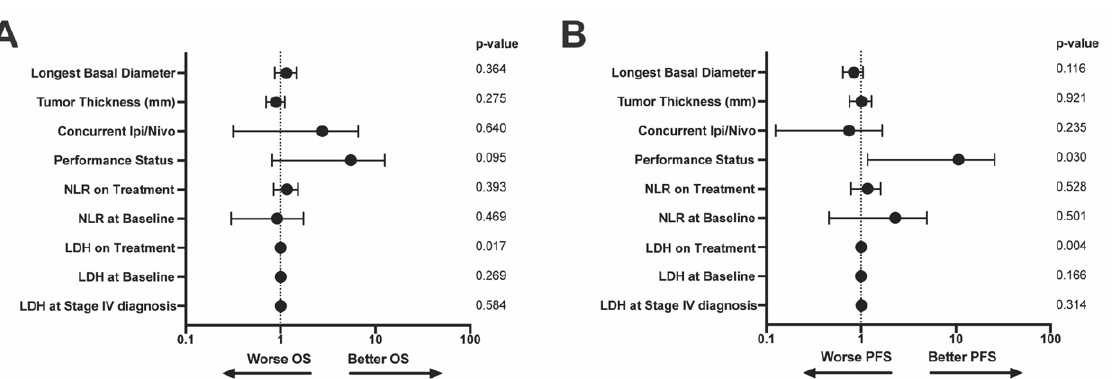
Figure 3. Multivariable model of ( A ) OS and ( B ) PFS. Variables included in the model are along the left y-axis. p -values associated with each variable are on the right y-axis. LDH = lactate dehydrogenase, NLR = neutrophil:lymphocyte ratio, OS = overall survival, PFS = progression free survival.